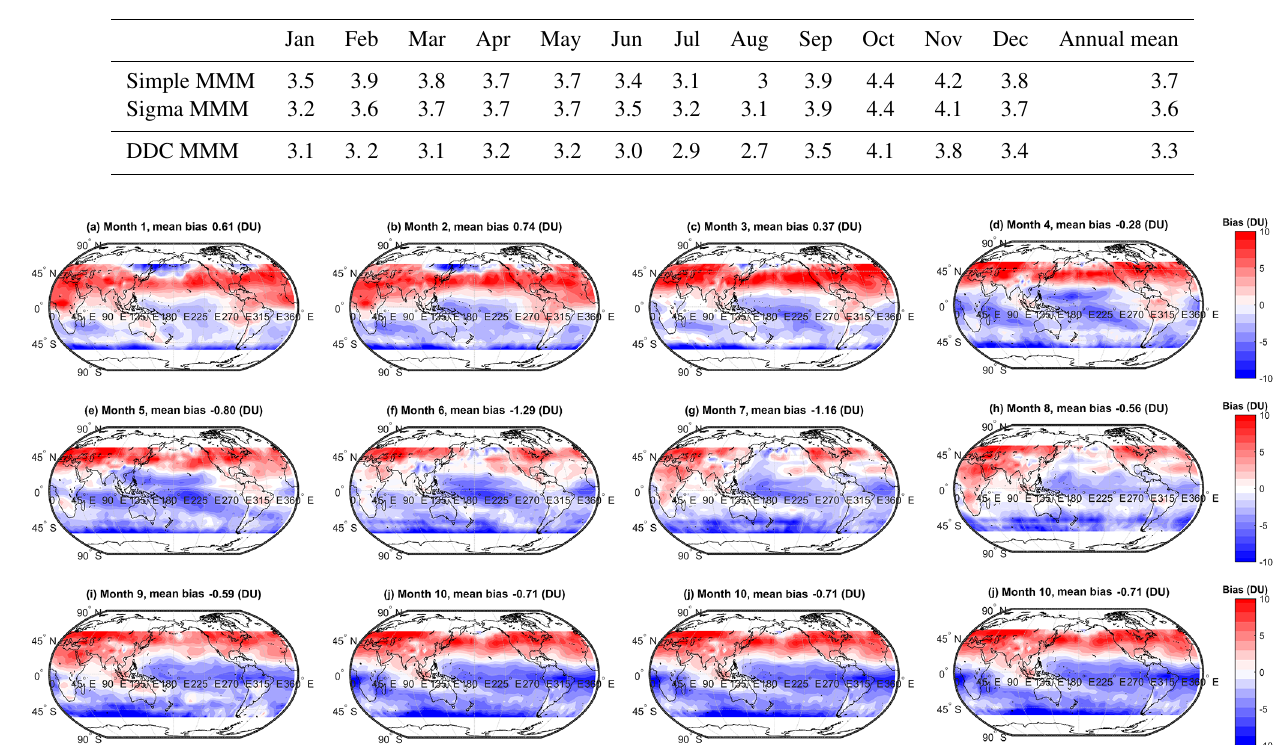
Table 3. As Table 2 but the absolute bias (DU) according to Eq. (2).